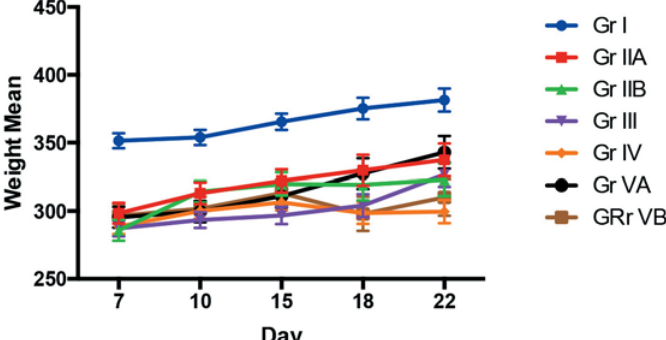
Figure 2- Results of the analysis of variance of animal weight in all experimental groups over study time. The results are presented as mean±standard error (SE) for all conditions tested